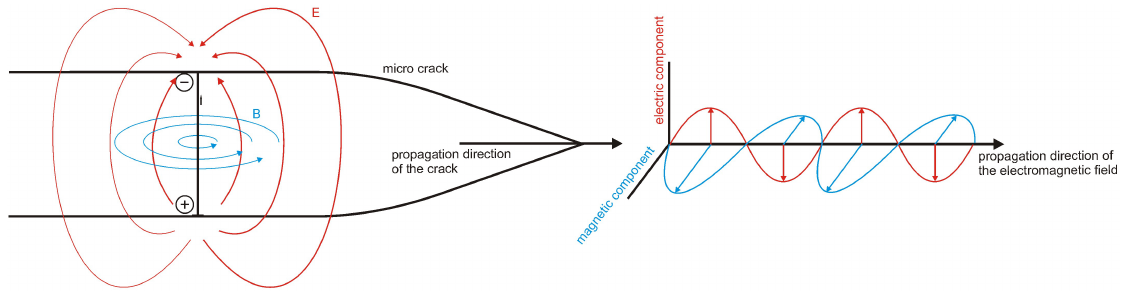
Fig. 1. Principal model of the polarisation of a micro-crack associated with electromagnetic emissions. During the formation and/or growth of a micro-crack, oscillating dipoles are generated that are orientated perpendicular to the micro-crack walls (Rabinovitch et al., 2007). Therefore, the measured magnetic component (B, blue) of the resulting electromagnetic field propagates parallel to the orientation of the micro-crack.